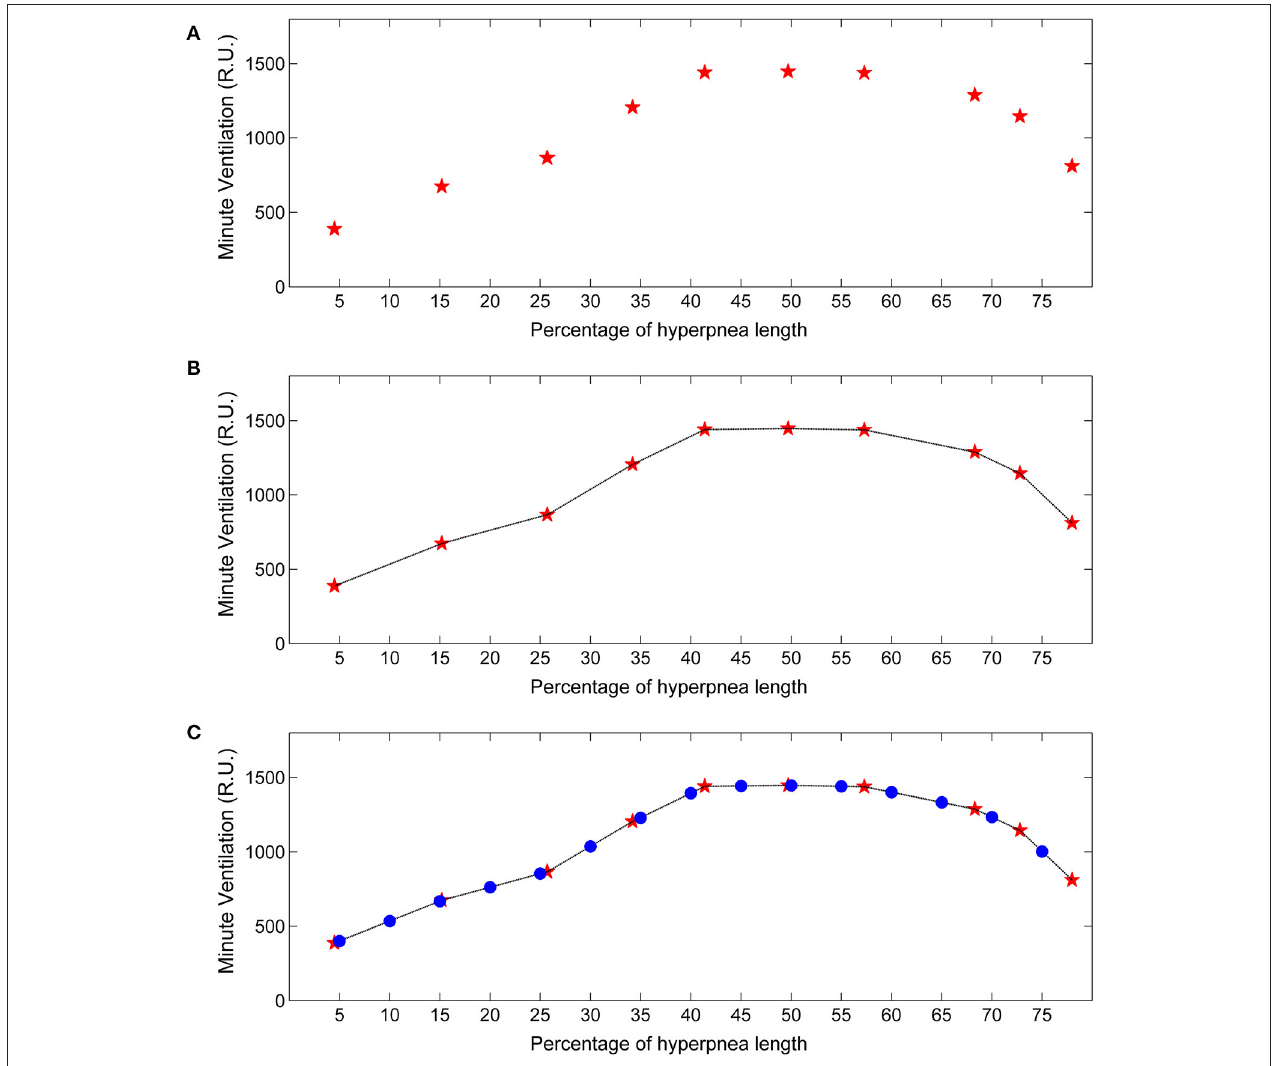
FIGURE 3 | Example of estimation of the time course of baseline minute ventilation during hyperpneas. (A) Raw time course of minute ventilation in the absence of arousals (see text). Red stars represent minute ventilation estimates for each consecutive breath of the hyperpnea (first, second etc.) as a function of percentage of hyperpnea length. (B) Linear interpolation of the estimates. (C) Minute ventilation was re-computed (blue dots) at predefined percentages of hyperpnea length (5, 10, 15%, ….) in order to compare the time course among patients. RU, relative units.